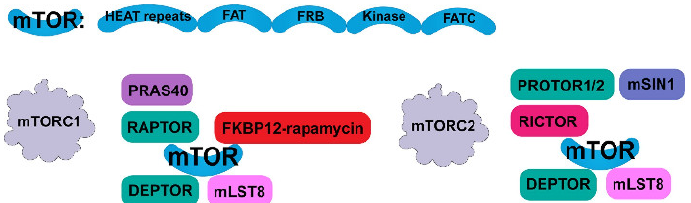
Figure 1. Architecture of mTORC1 and mTORC2. mTORC1 is mainly composed of mTOR, Raptor, mLST8, PRAS40, and DEPTOR. mTORC2 comprises mTOR, mLST8, Deptor, Rictor, mSIN1, and Protor1/2. mTOR is a complex protein composed of HEAT repeats and FAT, FRB, kinase, and FATC domains.